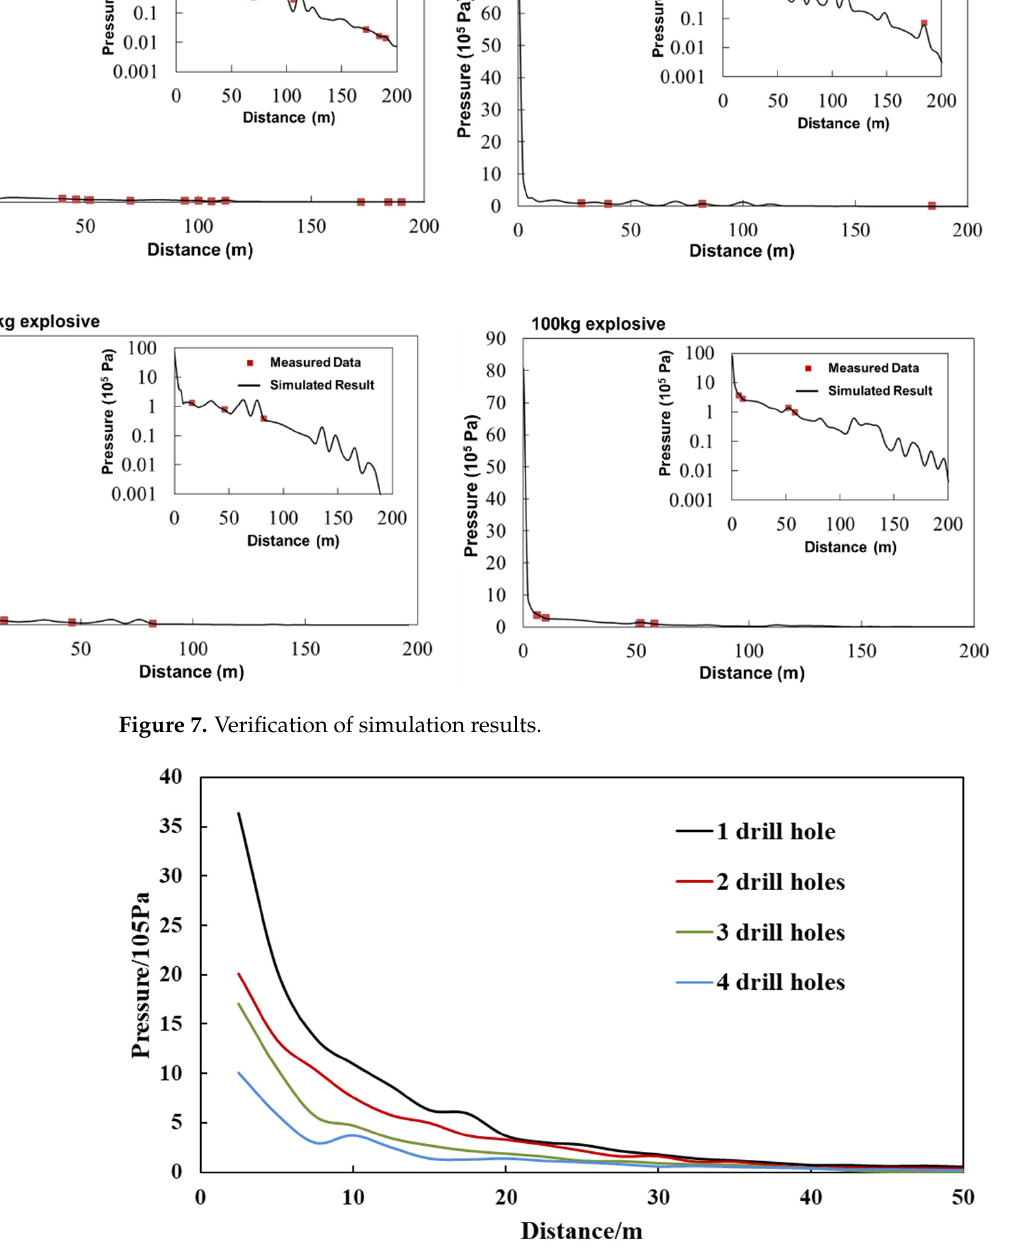
Figure 8. Transmission pattern of shock wave pressure with different numbers of holes.